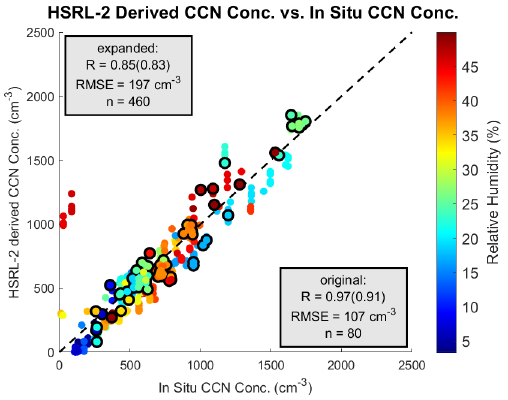
Figure 8. In situ CCN concentration versus HSRL-2-derived CCN concentration is given for an expanded 3-year data set (using d d = ± 4 . 4km and original time criteria and vertical bin sizes as given in Table 2). Supersaturation in the expanded data set ranges from 0.15%–0.4% compared to a range of 0.22%–0.4% for the origi- nal collocated data set. The points with a black outline designate those included in the original collocated data set that was used to develop the lidar-derived CCN concentration regression equation. The dashed line represents the 1 : 1 line, and for each data set the Pearson correlation coefficient is shown, with the Spearman rank correlation coefficient given in parentheses. This comparison shows the general applicability of our regression equations to derive CCN concentrations using HSRL-2 observables over a larger subset of the ORACLES